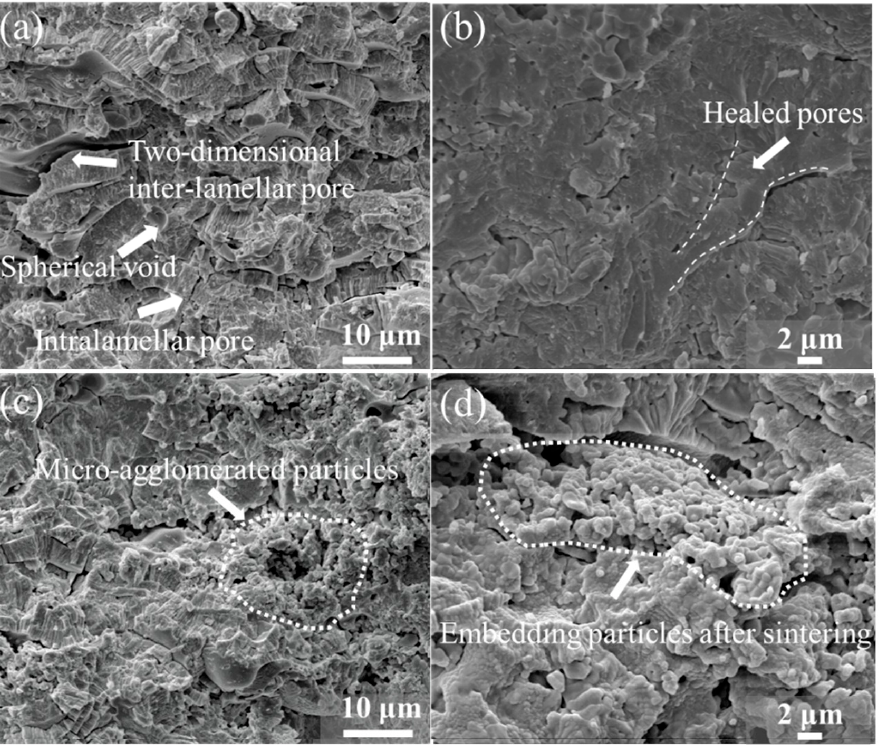
Figure 7. Fracture morphologies of the as-sprayed TBC and the TBCafter sintering at 1300 ◦ C for 40 h: ( a ) conventional TBC as-sprayed, ( b ) conventional TBC after sintering, ( c ) EMAP TBC as-sprayed, and ( d ) EMAP TBC after sintering.